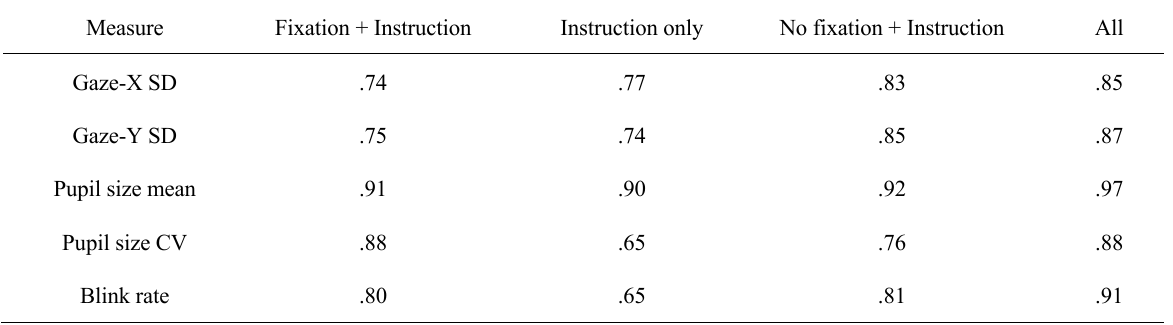
Table 3. Overview of the intra-class correlation coefficients of the average measure for each of the three conditions from Experiment 3, separately for each of the four measures, as well as the coefficients per measure over all conditions and days combined. Measure Fixation + Instruction Instruction only No fixation + Instruction All Gaze-X